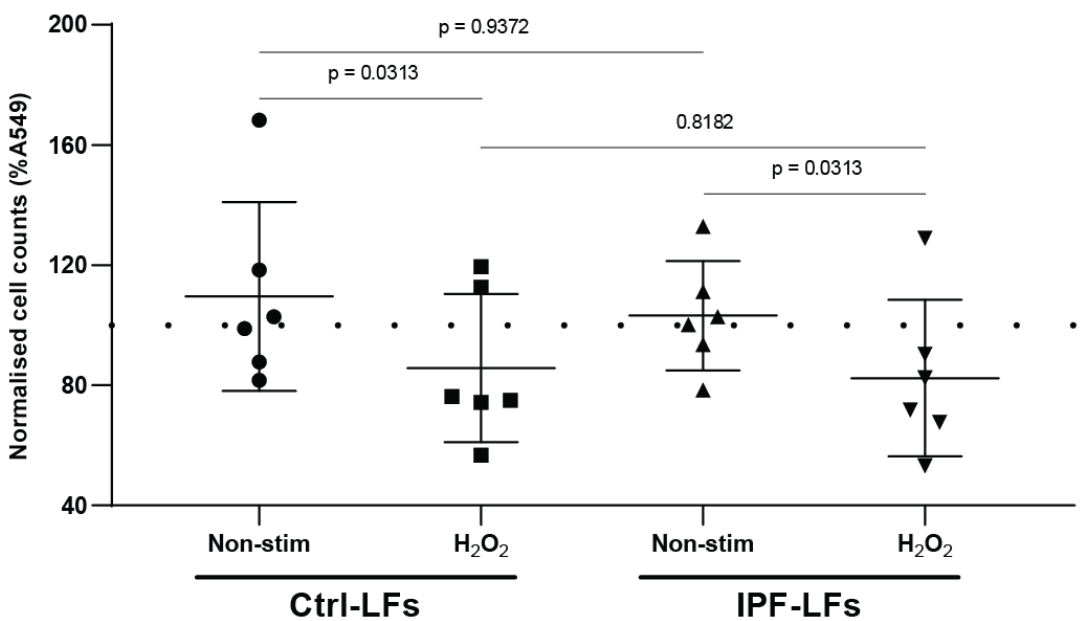
Figure 2. Conditioned medium from senescent LFs reduced proliferation of A549 cells. A549 cells were cultured in conditioned media from Ctrl-LFs ( n = 6) or IPF-LFs ( n = 6) fibroblasts. Fibroblast senescence was induced by stimulation with 150 µM H 2 O 2 for 2 hrs followed by recovery for 72 h, conditioned media transfer and cultured for 48 h. Proliferative potential of alveolar epithelial cells was measured by cell enumeration. All data were normalized to A549 baseline growth (dotted line, 100%) and expressed as mean ± SD, p < 0.05 was considered statistically significant, Wilcoxon matched-pairs rank test for non-stimulated and H 2 O 2 ; Mann–Whitney U for Ctrl-LFs vs. IPF-LFs at baseline.